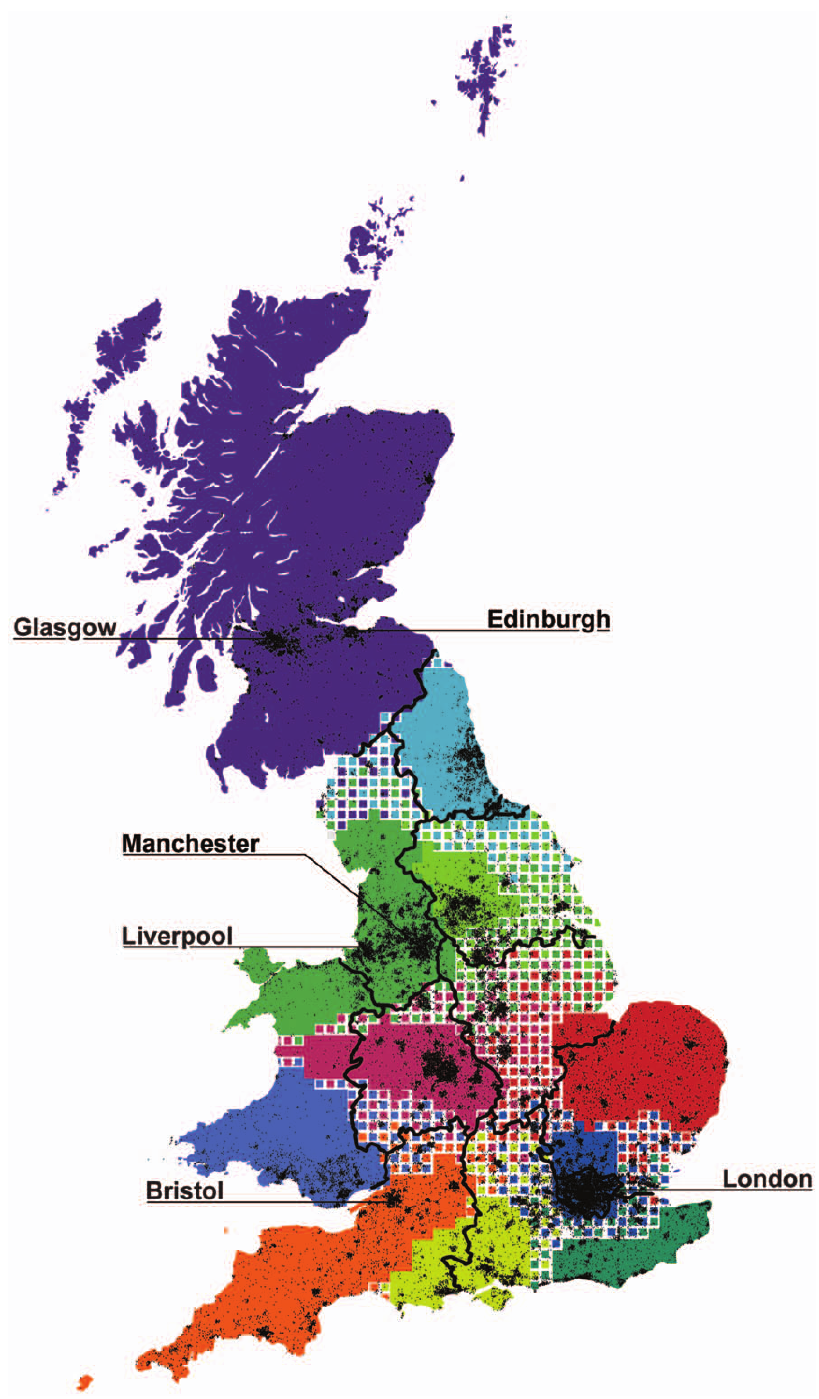
Figure 3. The core regions of Britain. By combining the output from several modularity optimization methods we obtain the results shown in this figure. The thick black boundary lines show the official Government Office Regions partitioning together with Scotland and Wales. The black background spots show Britain’s towns and cities, some of which are highlighted with a label.